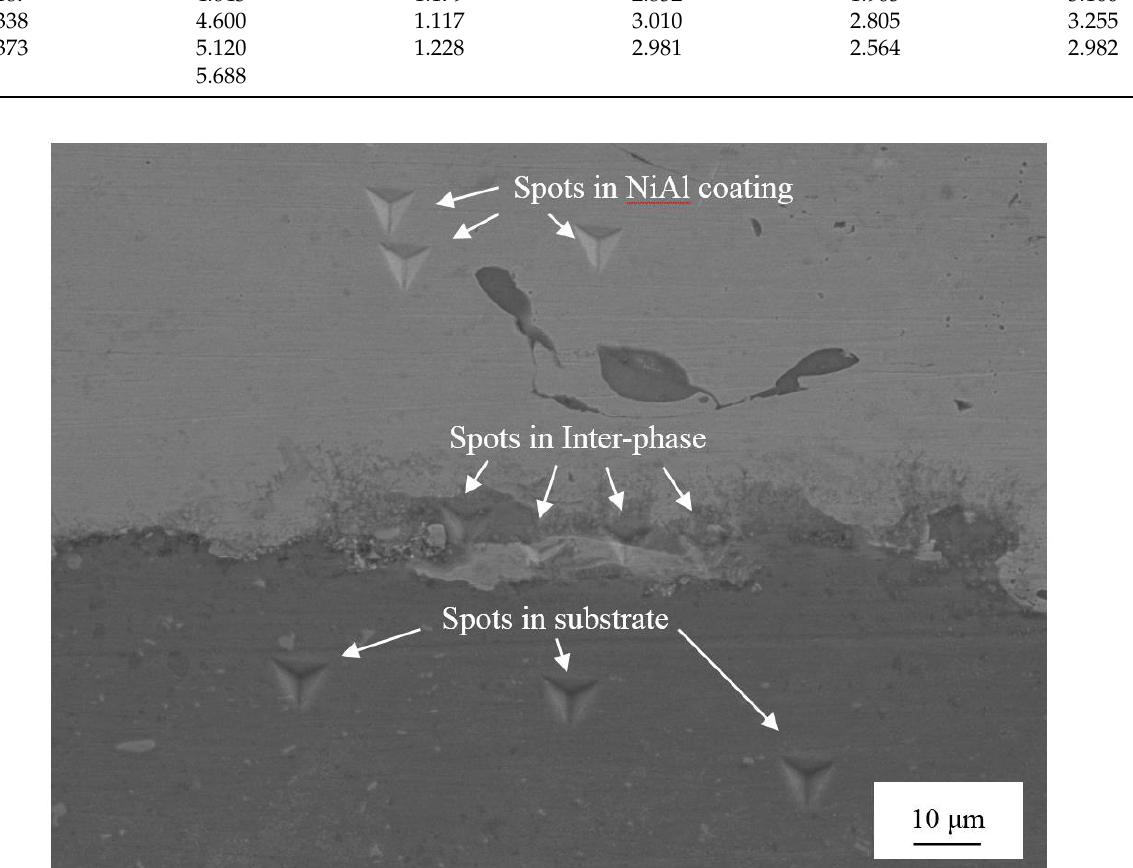
Figure 14. Microhardness testing spots at NiAl/7075 interface.